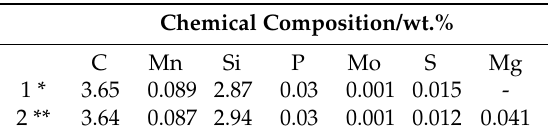
Table 1. Chemical composition of the examined ductile